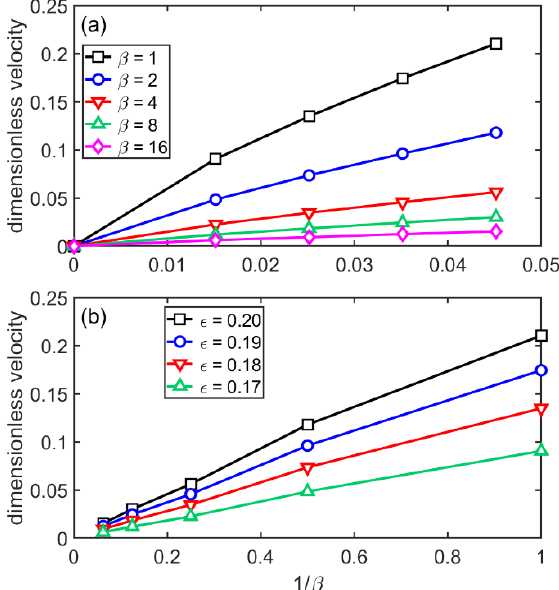
Figure 11. Dimensionless growth velocity, v as a function of ( a ) the reduced undercooling, and ( b ) the inverse of the viscosity parameter β as predicted by the sHPFC model ( α = the inverse of the viscosity parameter  as predicted by the sHPFC model (  = 0).